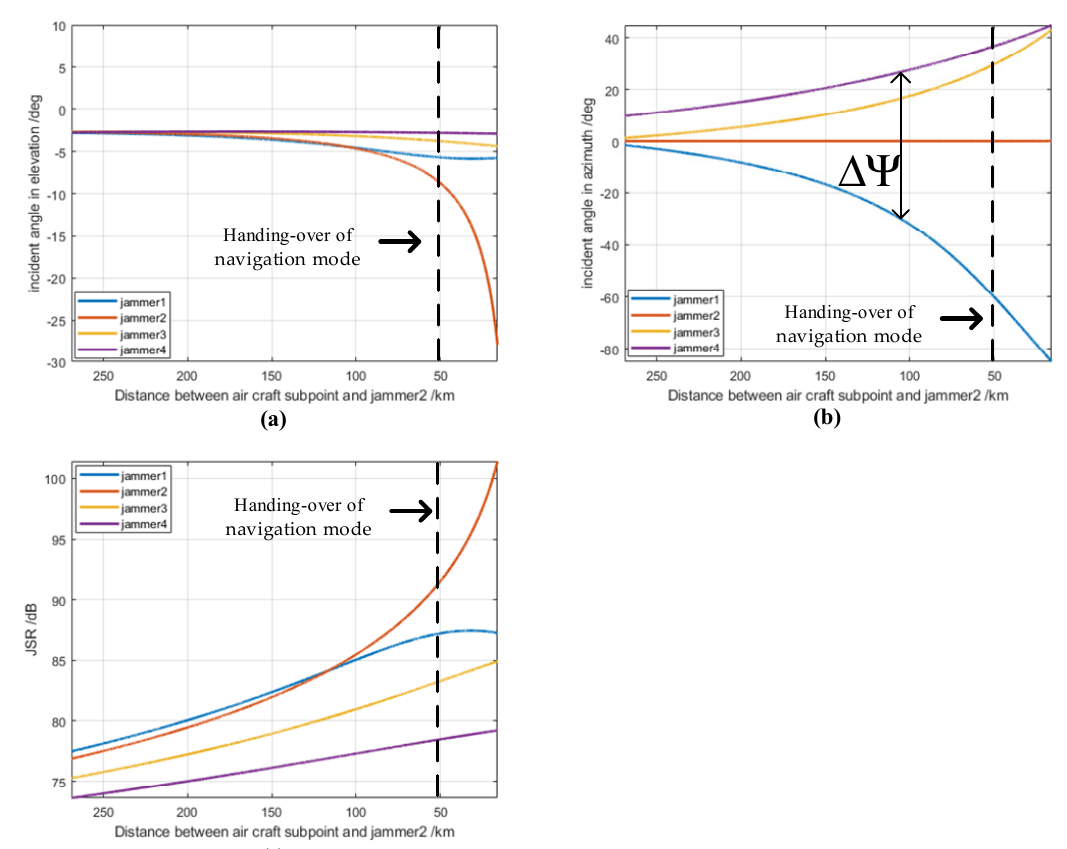
Figure 7. Jammer incident angles and JSR during the flight. ( a ) Incident angles in elevation. ( b ) Incident angle in azimuth. ( c ) JSR s increase as air craft gets closer to jammers.